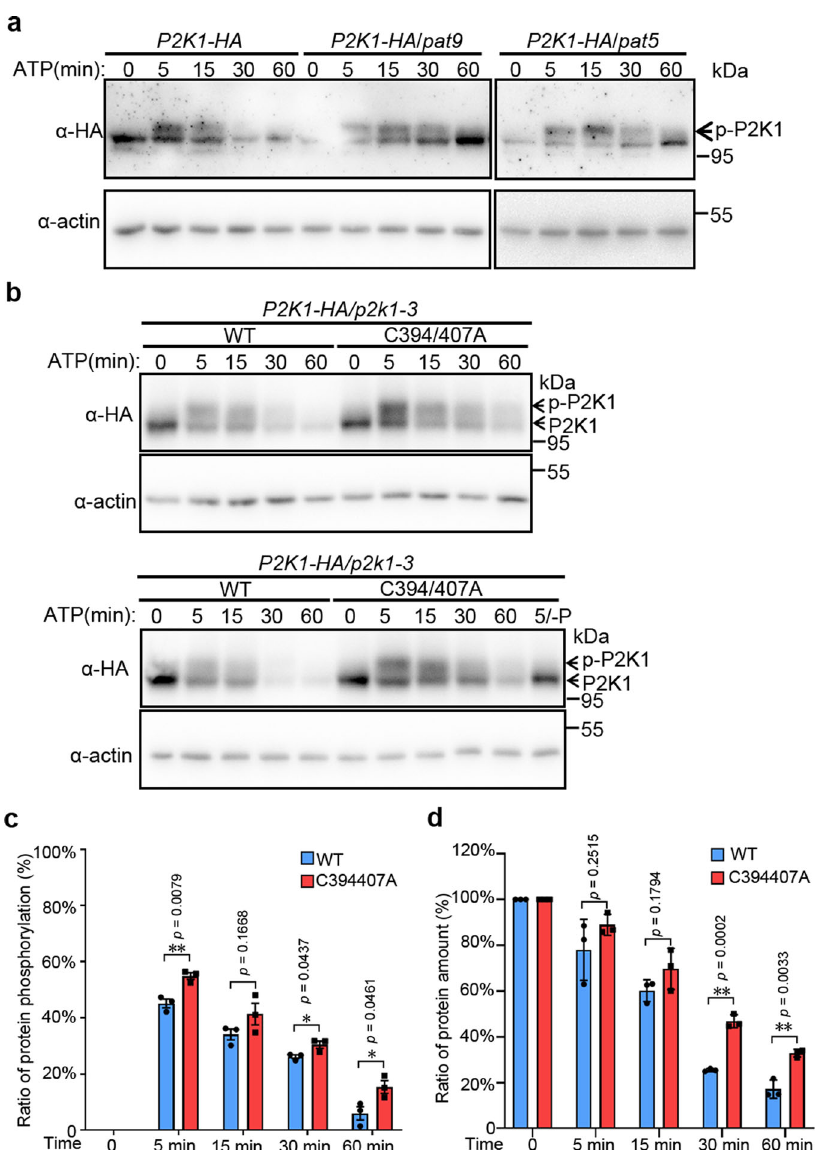
Fig. 5 PAT9 regulates ATP-induced P2K1 phosphorylation and turnover. a PAT5/9 controls P2K1 phosphorylation and turnover. P2K1-HA was analyzed by immunoblot in wild type and Atpat5 and Atpat9 mutants background upon addition of 400 μ M ATP. p-P2K1 phosphorylation of P2K1. Actin protein was used as loading control. Experiments were repeated three times with similar results. b – d Analysis of turnover and phosphorylation of P2K1 proteins modi fi ed (C → A) at the site of S -acylation. The indicated constructs were expressed into Arabidopsis p2k1-3 mutant plant and treated with 400 μ M ATP. Lambda PP (-P) was added to release phosphate groups. In panel c and d , the ratio of P2K1 protein phosphorylation and total protein amount were measured from panel b and another replicate with Image J. Error bars indicate ±SE; n = 3 (biological replicates). * p < 0.05, ** p < 0.01, P -values indicate signi fi cance relative to WT and were determined by one-sided ANOVA with unpaired, two-tailed Student ’ s t